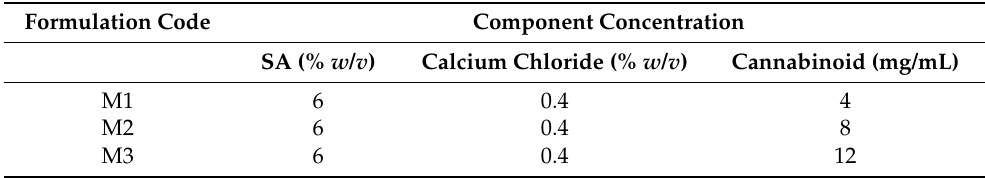
Table 1. Ingredient concentrations in the loaded